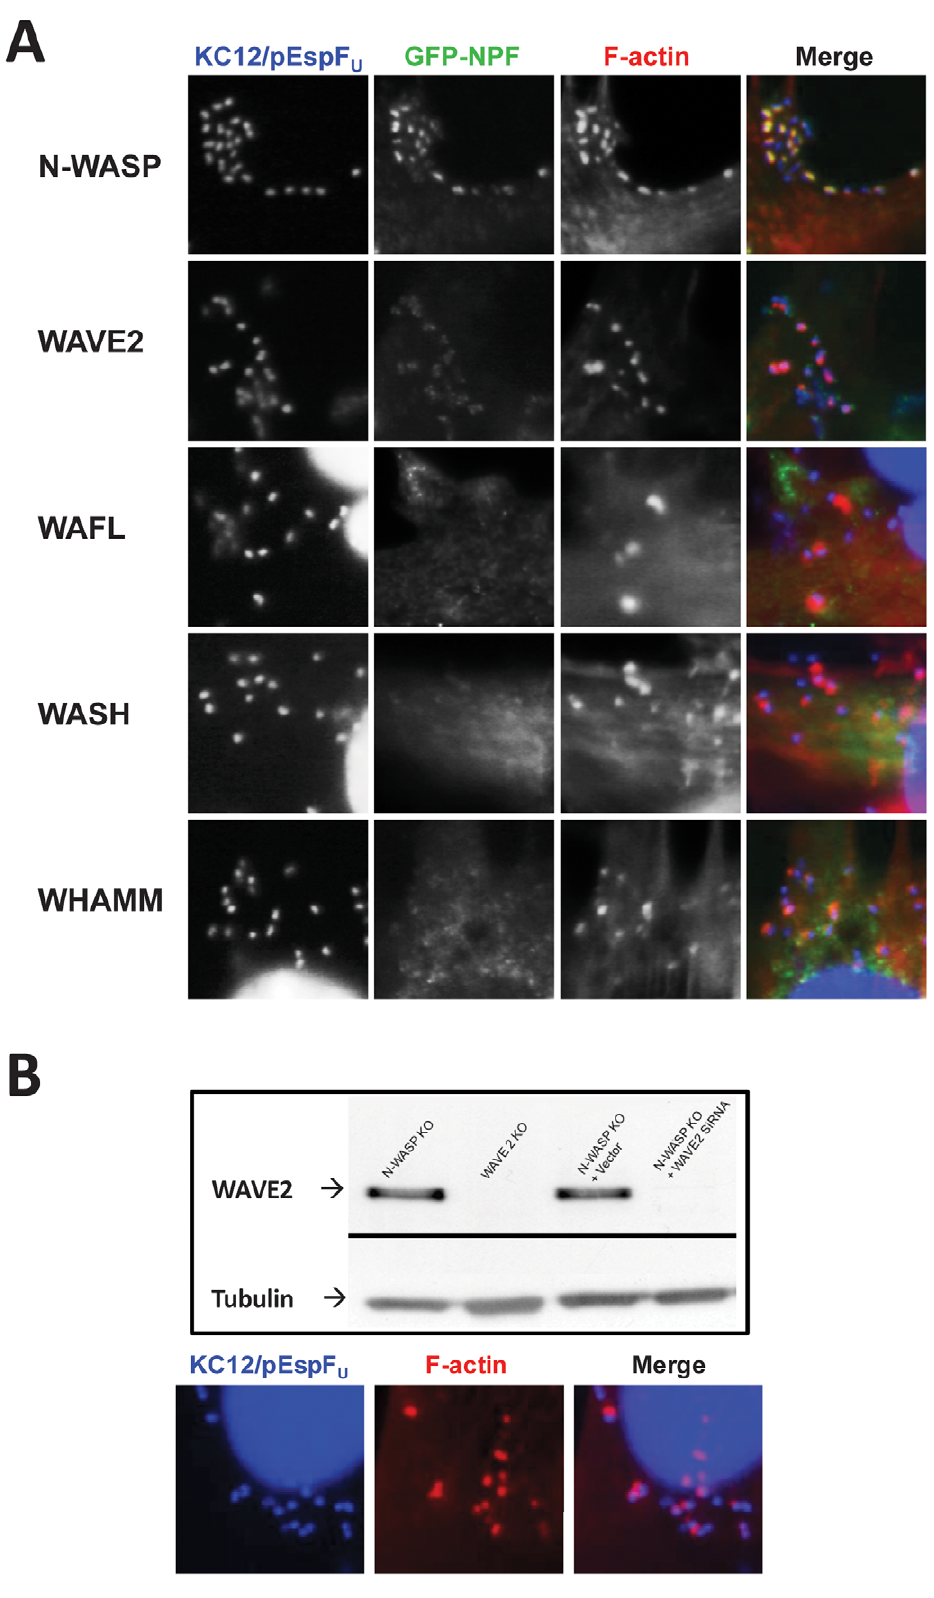
Figure 7. WASP/WAVE family members that are not involved in pedestal formation. ( A ) NW 2 / 2 fibroblast-like cells ectopically expressing GFP fusions to WASP/WAVE family members N-WASP, WAVE2, WASH, or WHAMM, or to WAFL, were infected with EPEC KC12/pEspF U , and examined after staining with DAPI to detect bacteria (blue) and Alexa568-phalloidin to visualize F-actin (red). ( B ) Genetic depletion of WAVE2 in N-WASP knockout cells does not affect pedestal formation. Extracts from NW 2 / 2 cells, WAVE2 2 / 2 cells, or NW 2 / 2 cells harboring control vector or one